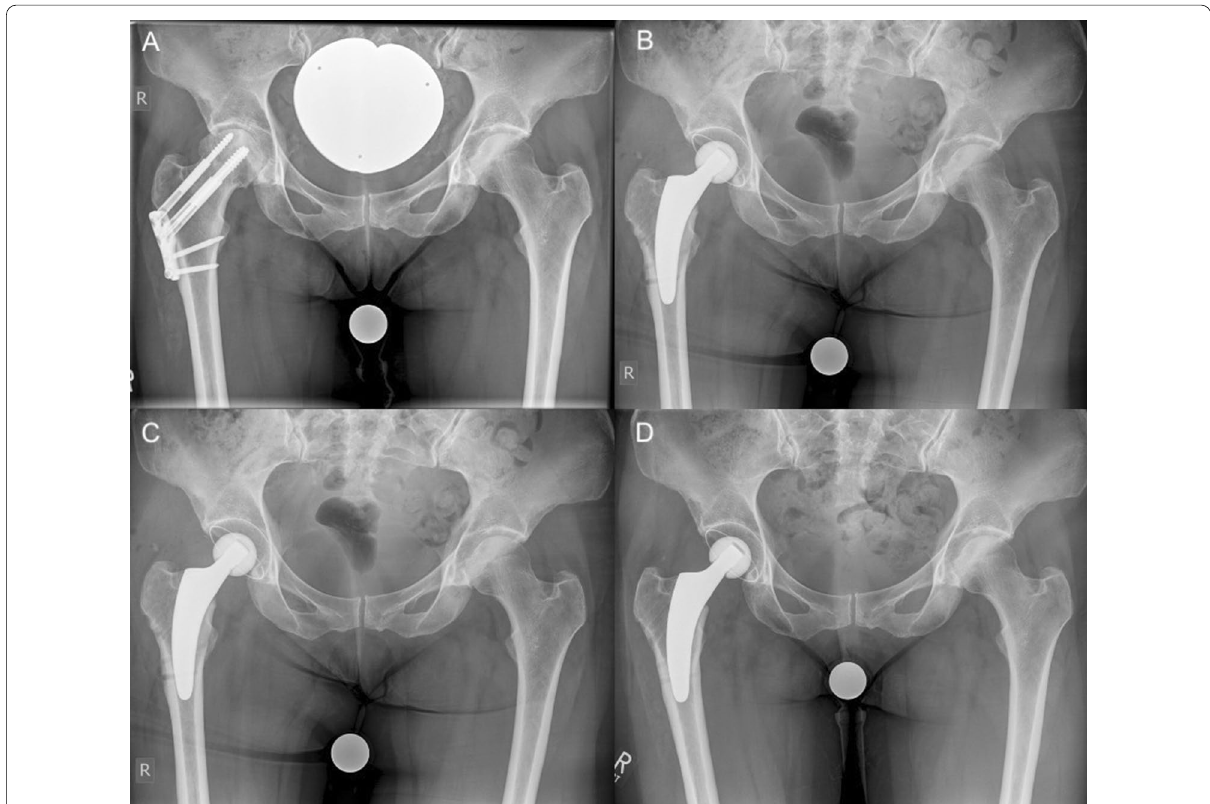
Fig. 3 Radiographs of a 53-year-old female patient with secondary osteoarthritis: A preoperative; B postoperative; C 6-week follow-up D : 26-month follow-up (no signs of loosening or